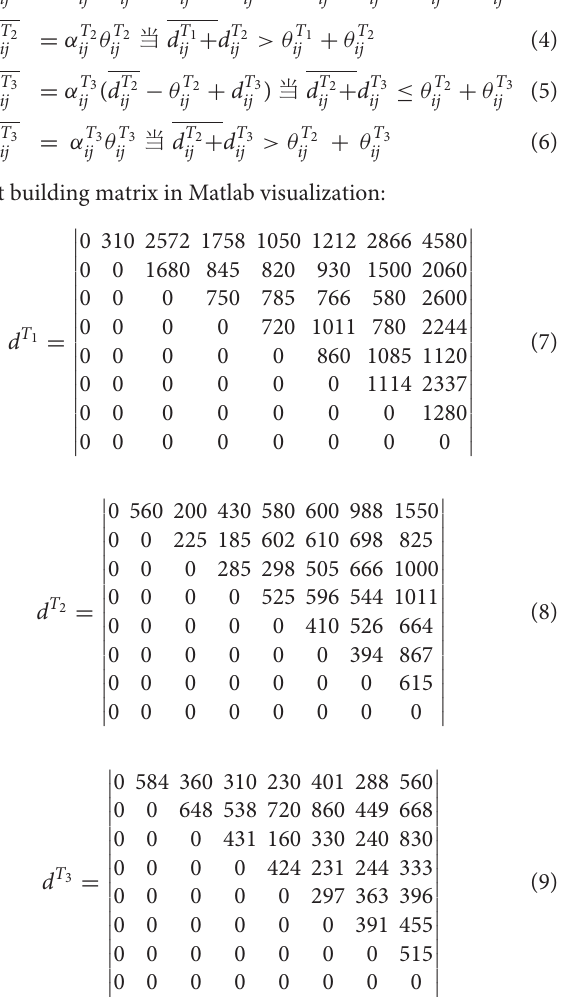
According to the above particle swarm and acoustic algorithm, the program solution is used, and the number of iterations is 3,500 times. The convergence curve is shown in the following figure. The calculation results are as follows (shown in Figure 4